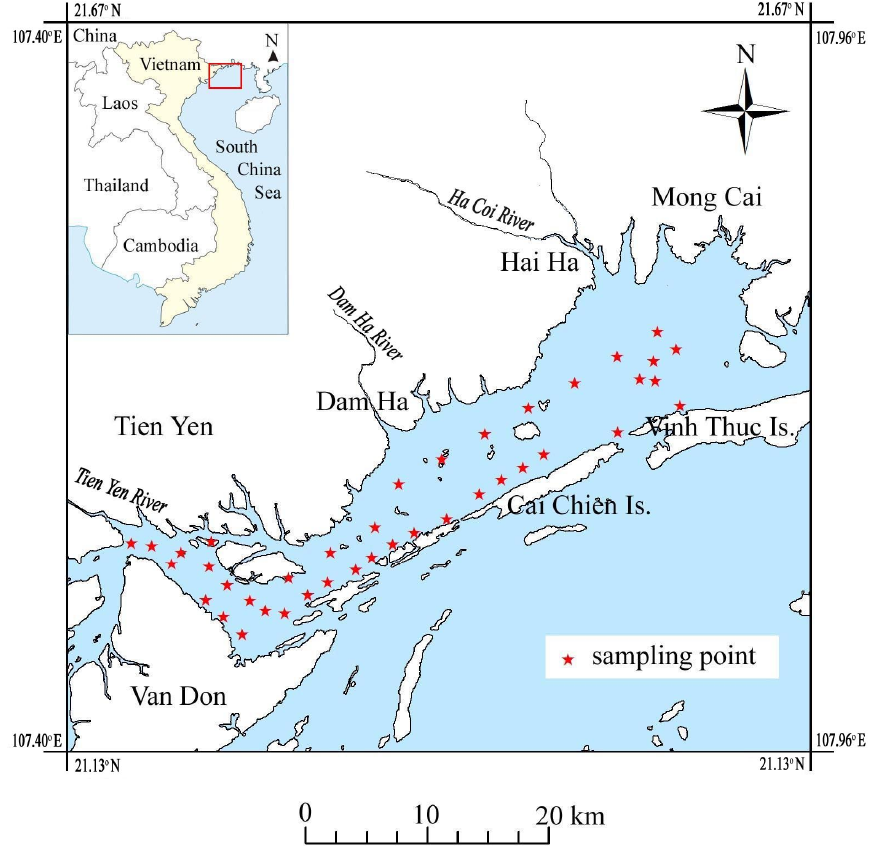
Figure 1. Location of Tien Yen Bay in northern Vietnam and the positions of 40 sampling points for measuring Chl-a